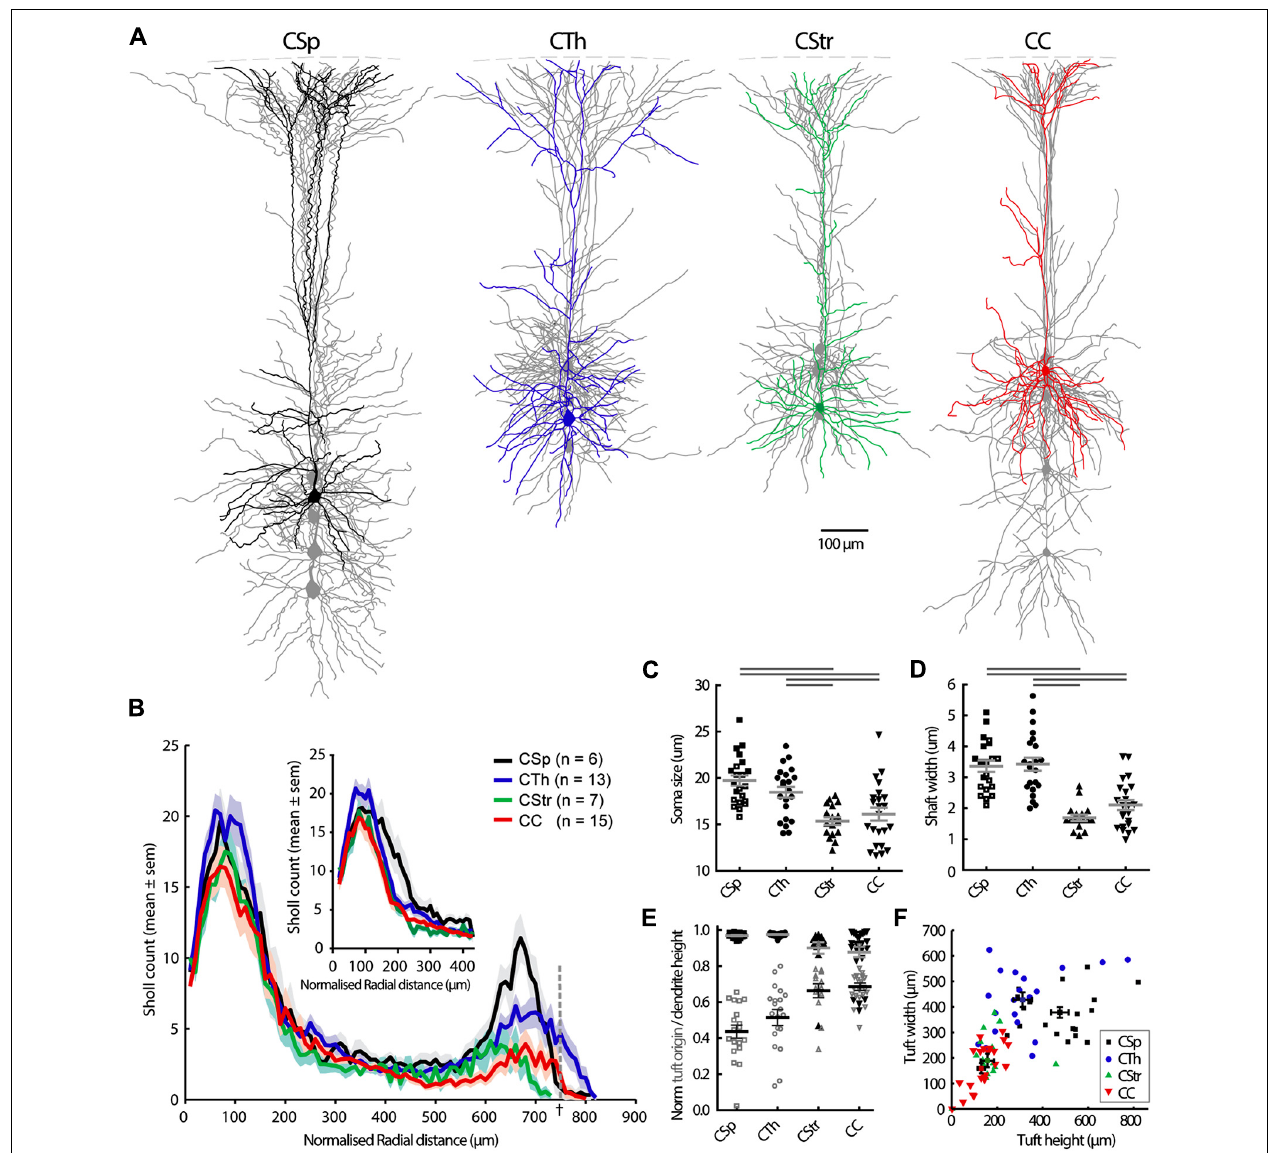
cortical depth and muliplied again by the average cortical depth (inset for basal dendrites only). Cell groups differed mainly in the distal apical tuft region ( p < 0.001, two-way ANOVA). Soma size and shaft width ( C, D , filled and open squares respectively for lumbar and cervical CSp neurons). Hori- zontal gray bars indicate group-wise differences at the 5% significance level ( C , one-way ANOVA and Tukey’s post hoc test; D , Kruskal-Wallis test and Dunn’s post hoc analysis). Apical dendrite height ( E , filled black symbols, gray lines for mean ± SEM) and tuft origin (open gray symbols, black lines for mean ± SEM). (F) Overall correlation of tuft width and height showing data from individual neurons and the mean ± SEM for each